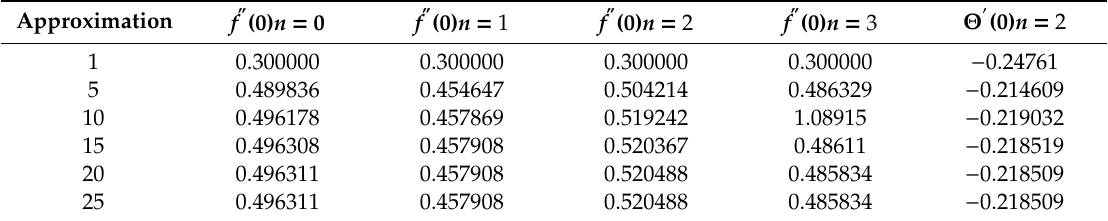
Table 1. The Homotopy Analysis Method (HAM) convergence table up to 25th order